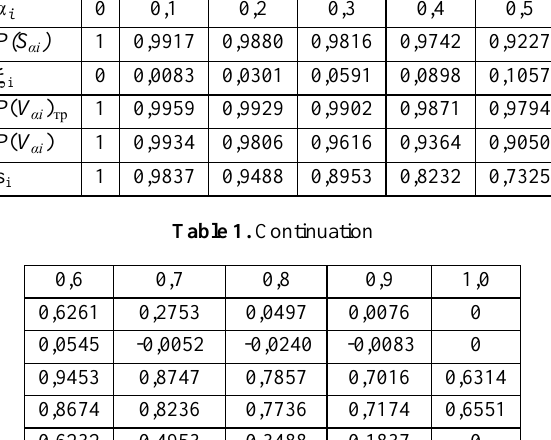
Fig. 3. Profilogram and diagram of filling the rough layer with a material along the 0-100 section of the profilogram depicted on fig. 2. Table 1. Results of probabilistic parameters calculation along the length 0 -100 mm of the profilogram.